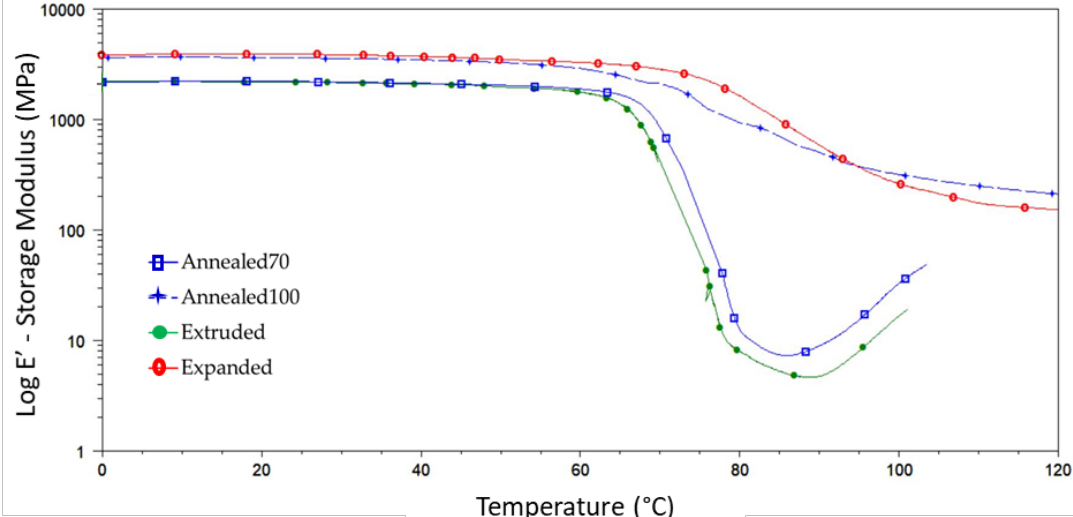
Figure 8. DMA (Dynamic Mechanical Analysis) overlay of the storage modulus plots from the Extruded, Annealed70, Annealed100 and Expanded tubing.